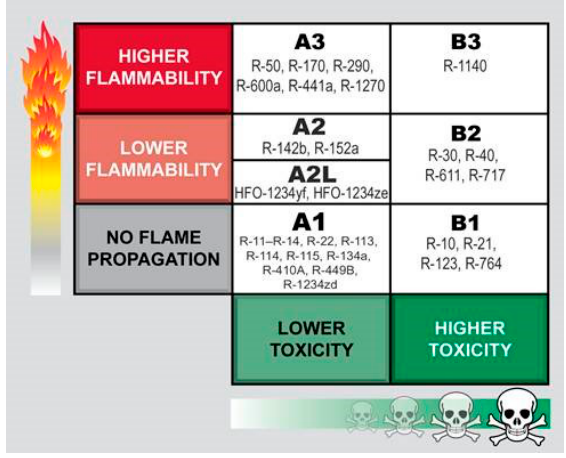
Figure 5. Refrigerant classification. Table 1. Properties of 22, R407C, R417A, and R422A. Note: ODP, ozone-depletion potential; GWP,